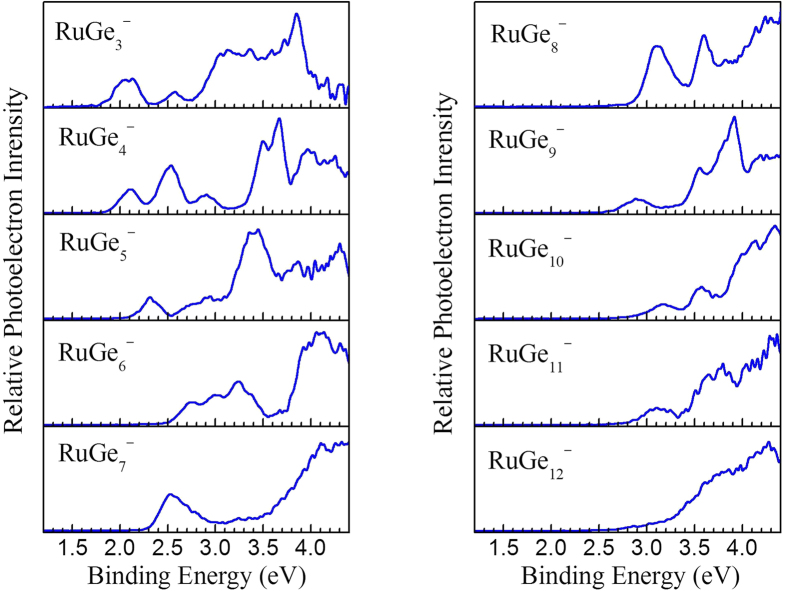
Experimental photoelectron spectra of RuGen− (n = 3–12) clusters recorded with 266 nm photons.